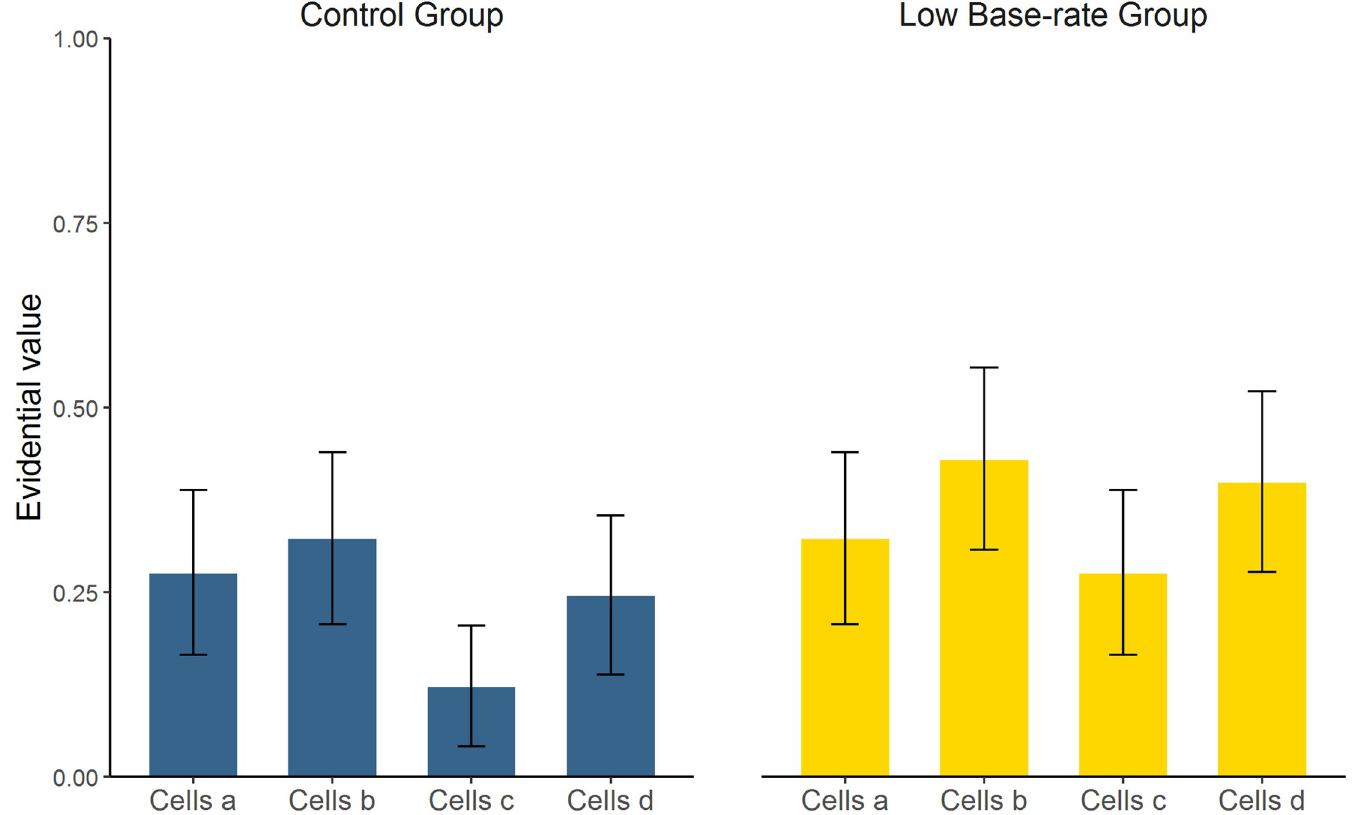
Fig 6. Mean proportion of “evidence” answers to the evidential value questions in Experiment 2, by type of trial: cells a , b , c , and d . Error bars depict 95% CIs for the mean.